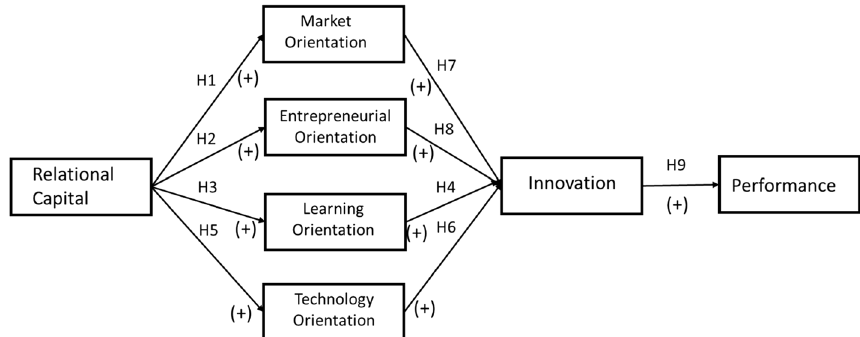
Fig. 1 Model proposed. Source: